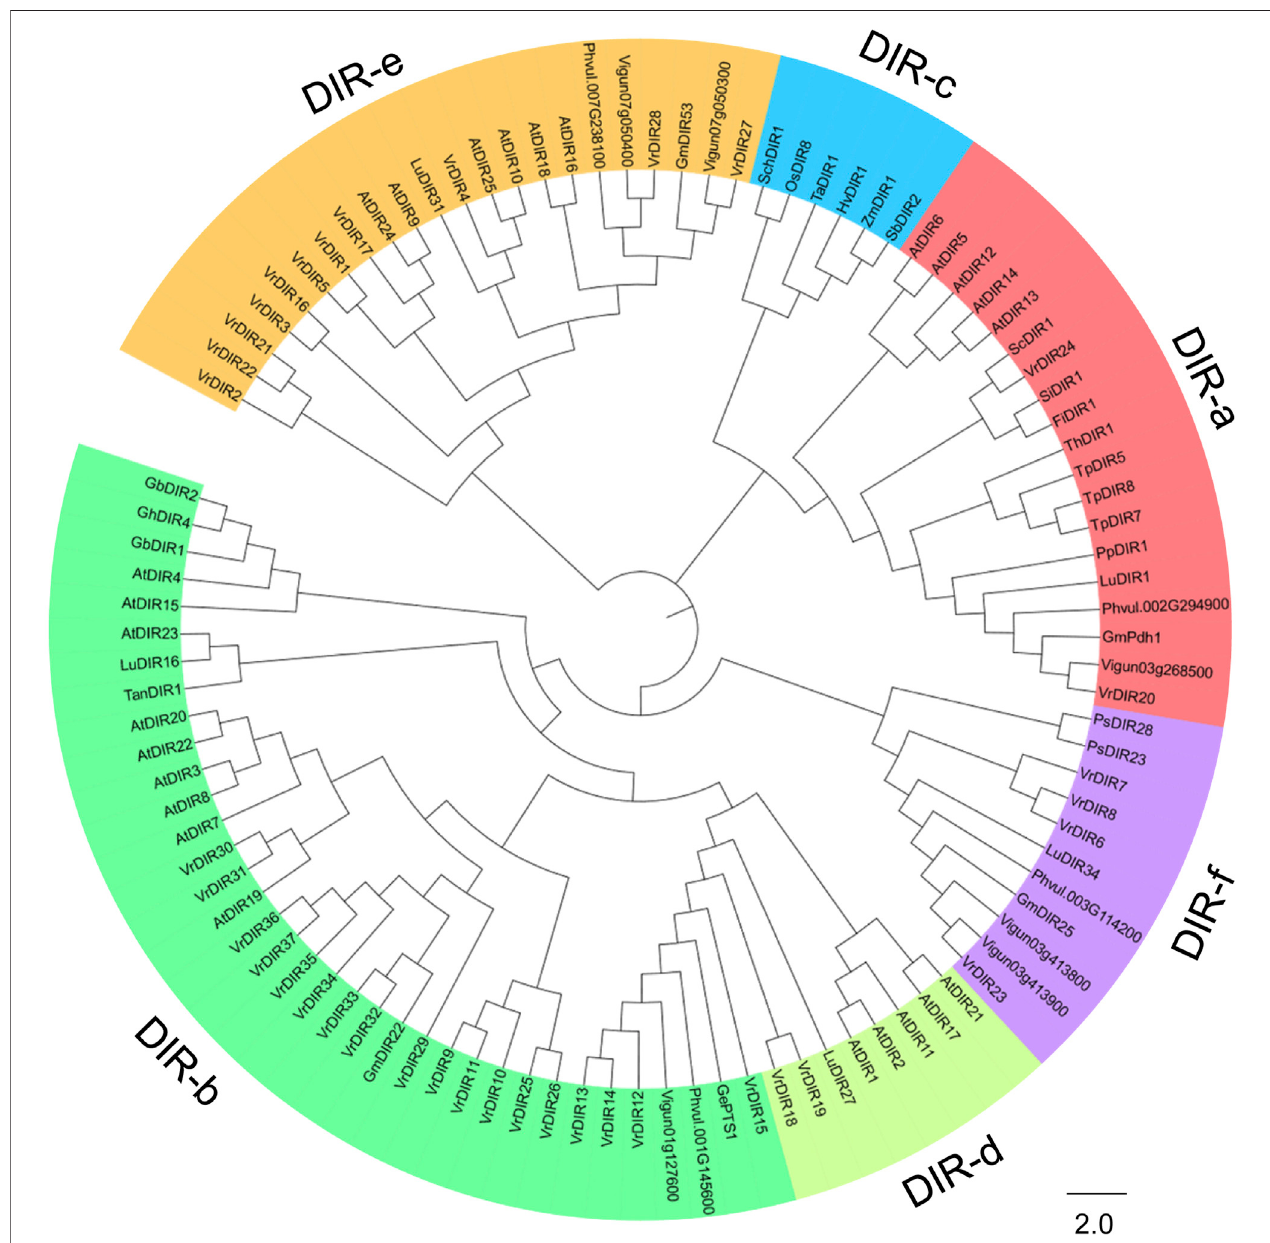
FIGURE 1 | Analysis of the evolutionary relationships of DIR proteins from mungbean and other species. The amino acid sequences of DIR proteins from mungbean, Arabidopsis , and other species reported by Corbin et al. (2018) were used to conduct the phylogenetic analysis in MEGA 7.0 using the neighbor-joining method. DIR proteins were classi fi ed into six groups based on their phylogenetic relationships, DIR-a to DIR-f, which are indicated by different colors in the phylogenetic tree.